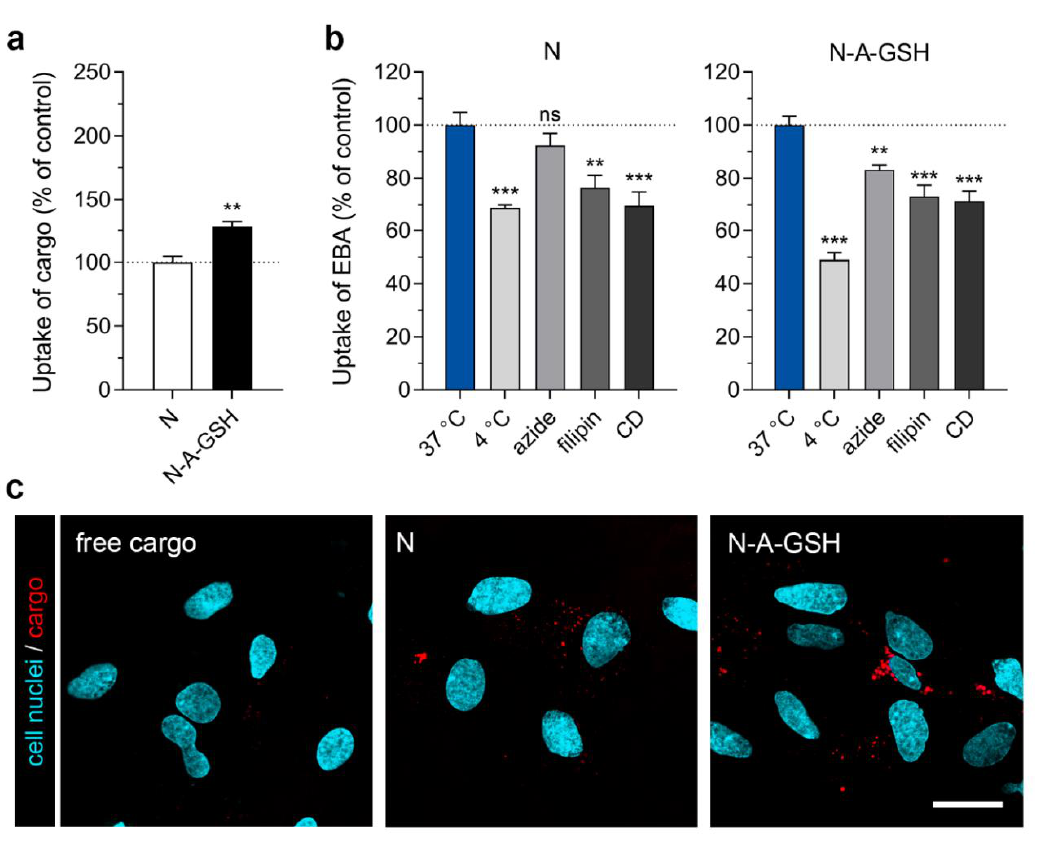
Figure 5. Cellular uptake of niosome cargo in cultured primary rat astrocytes (RAC) after 4 h of incubation. ( a ) Uptake of cargo loaded in non-targeted (N) and alanine-glutathione targeted (N-A-GSH) niosomes. Values presented are means ± SEM. Statistical analysis: unpaired t test; ** p < 0.01; n =